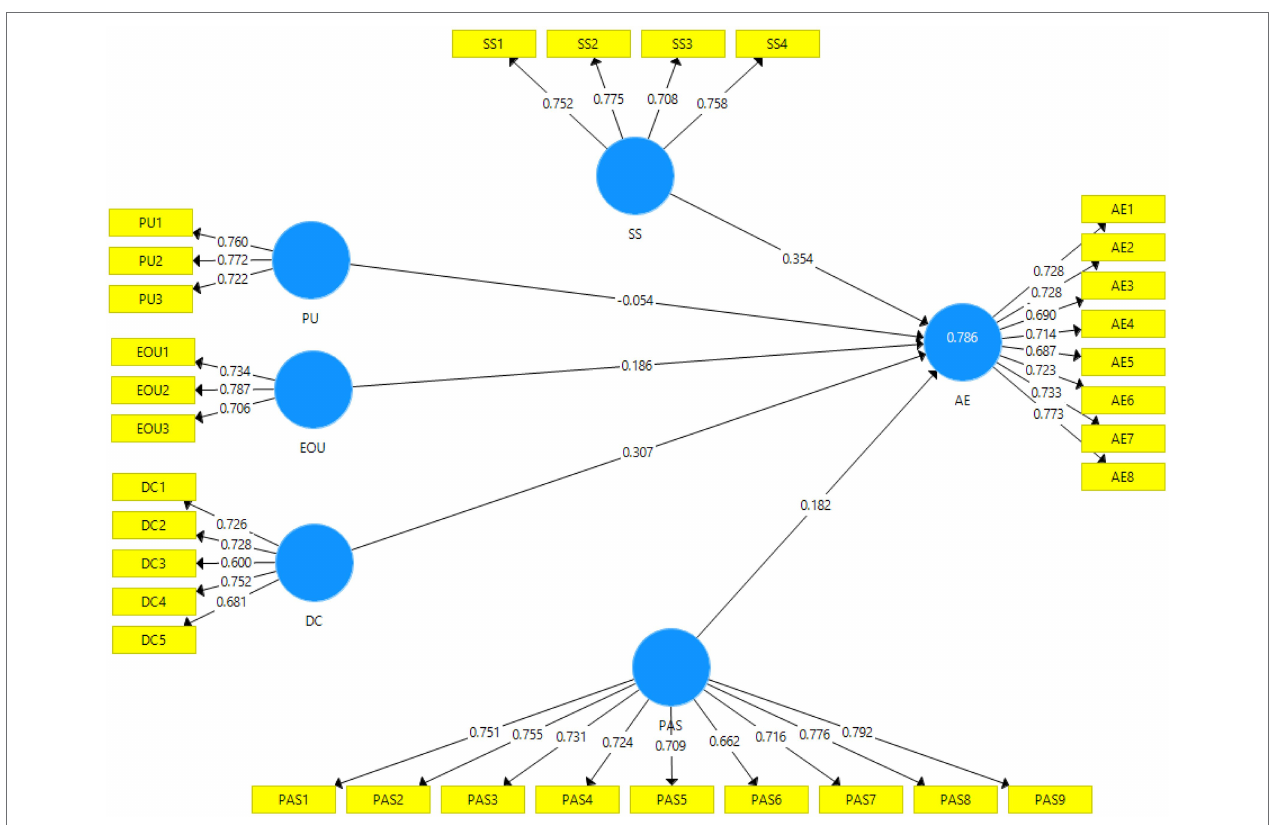
FIGURE 2 | Measurement